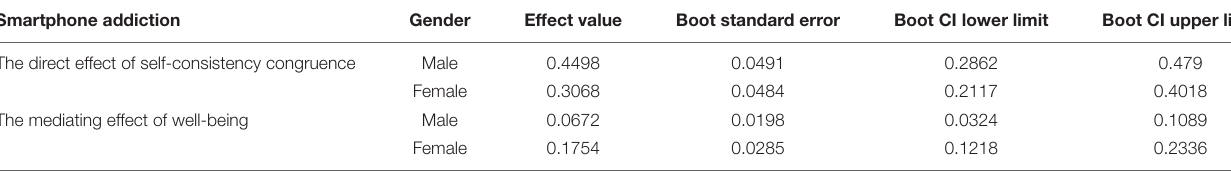
TABLE 4 | Direct and mediating effects under different gender